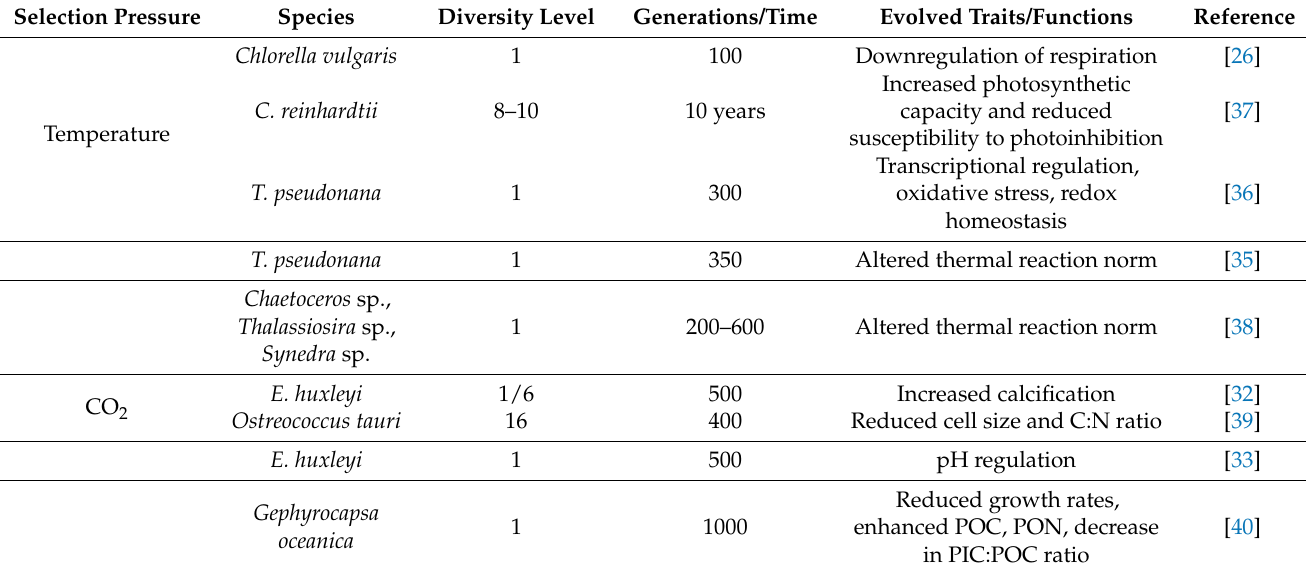
Table 1. Examples of studies from the field of experimental evolution showing adaptive evolution in phytoplankton as a response to increased temperature or CO 2